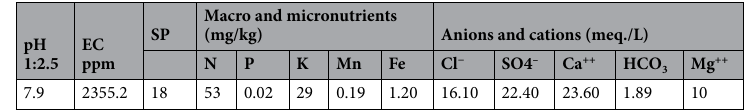
Table 2. The physical and chemical properties of the experimented